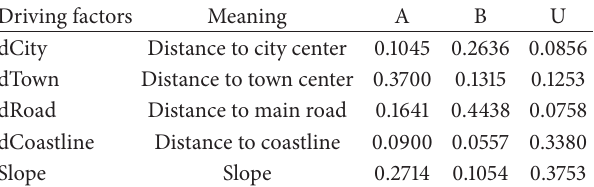
Table 3: Weights of driving factors.